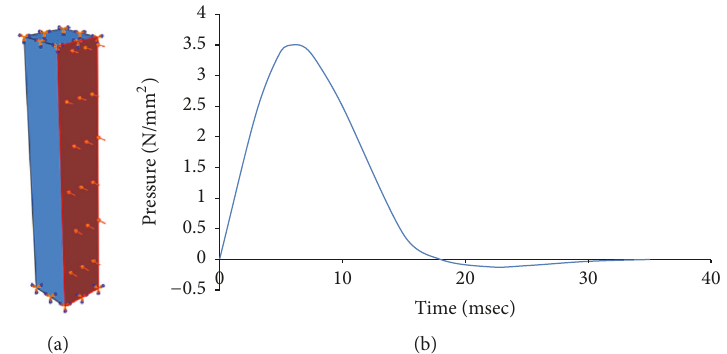
Figure 5: Blast pressure-time history (b) and applied blast load (a).